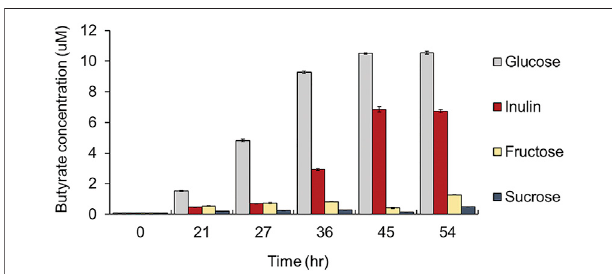
FIGURE 2 | Comparison of butyrate productivity of F. prausnitzii grown in mYCFA supplemented with either glucose, inulin, fructose, or sucrose. All experiments were performed in triplicates for each